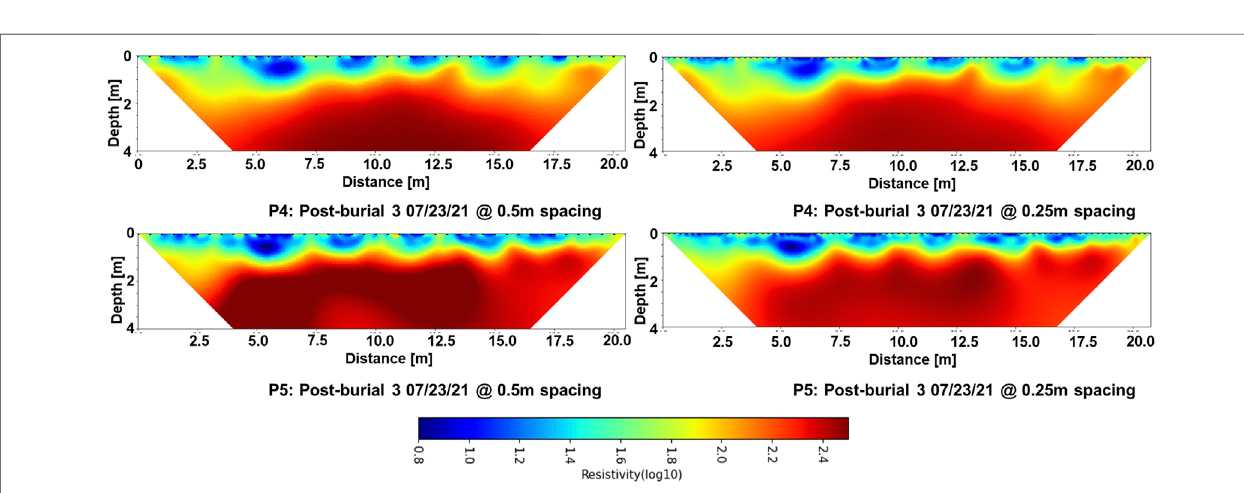
Frontiers in Environmental Science |